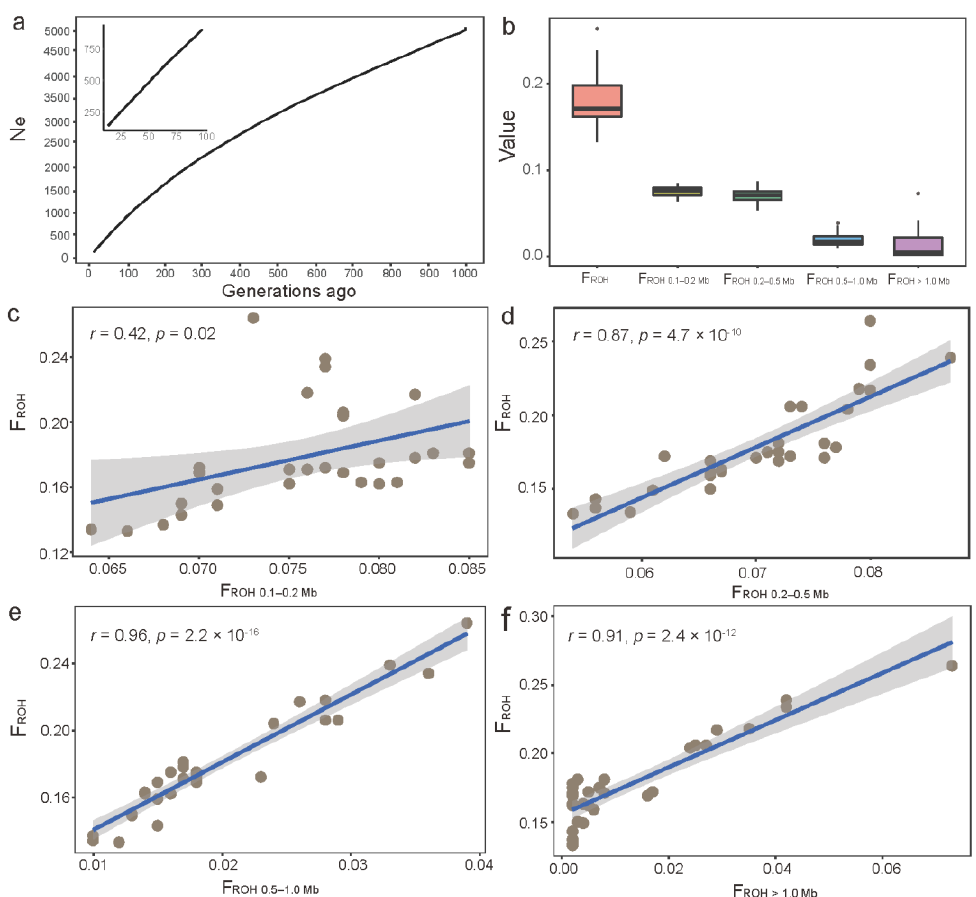
Figure 3. ROH-based genomic inbreeding coefficients in JC goats. ( a ) The estimated effective population size of JC goats during the past 1000 generations. ( b ) Summary of ROH-based genomic inbreeding coefficients (F ROH ) in JC goats. The plots ( c – f ) show the Pearson’s correlation between F ROH and the partial inbreeding levels based on the ROHs with four different length categories (i.e., F ROH 0.1–0.2 Mb , F ROH 0.2–0.5 Mb , F ROH 0.5–1 Mb , and F ROH > 1 Mb ) in JC goats.